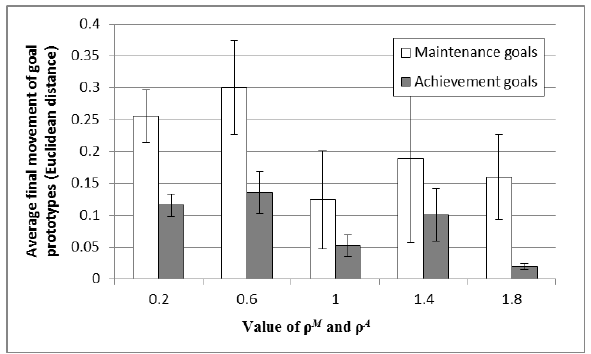
Figure 12: Expt 2: Impact of non-linear distance metric, ρ A and ρ M on number of of achievement (grey) and maintenance goals (white).